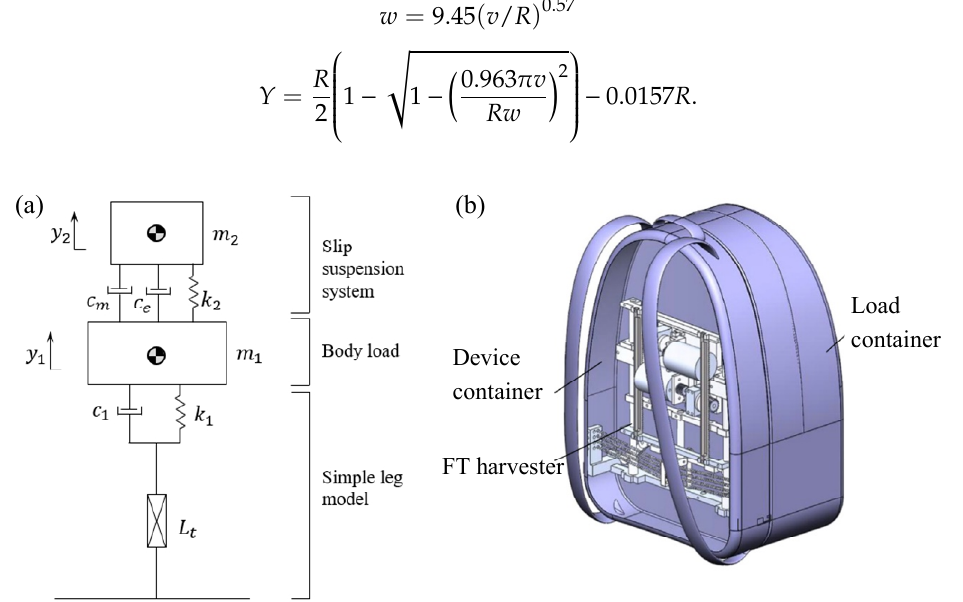
Figure 1. Schematic of the FT harvester: ( a ) Spring-mass-damper slip model; ( b ) FT energy harvester assembly mounted in the backpack [17].